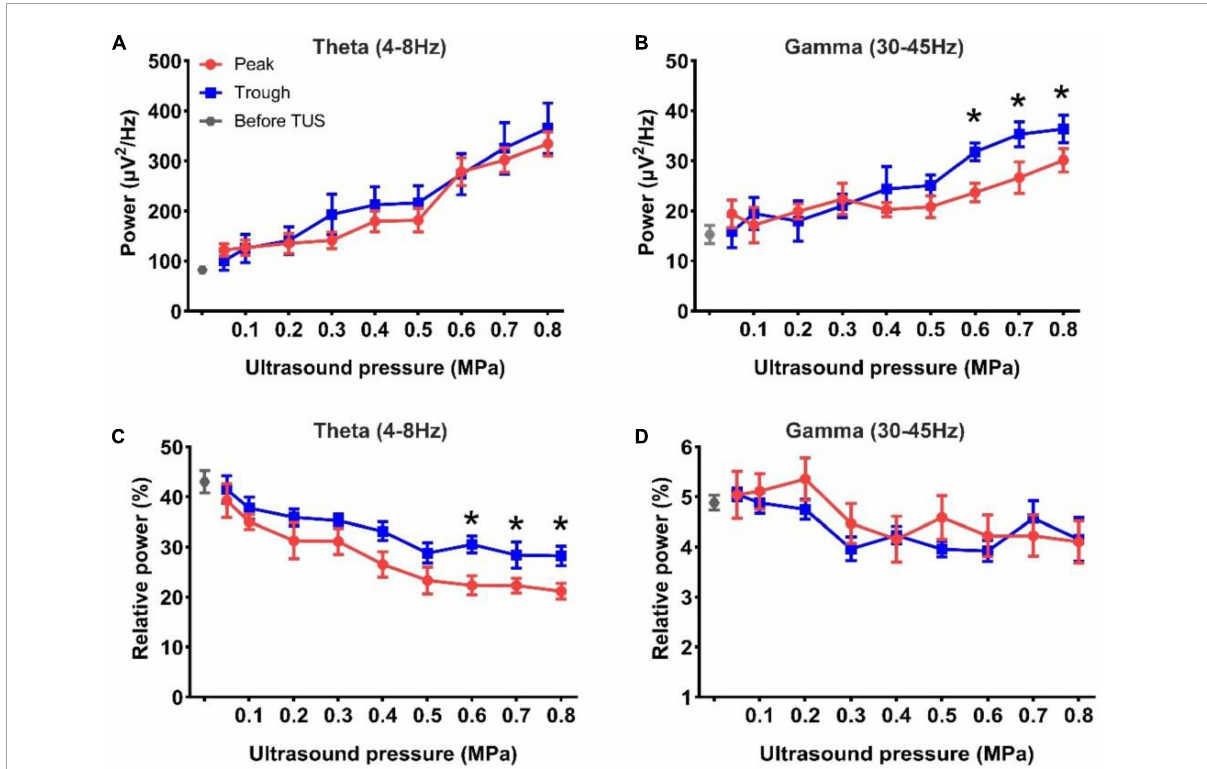
FIGURE3 (A,B) The absolute power of the theta and gamma rhythms before and after TUS under peak and trough stimulations with different ultrasound pressures, (A) theta rhythm, (B) gamma rhythm. (C,D) The relative power of the theta and gamma rhythms before and after TUS under peak and trough stimulations with different ultrasound pressures, (C) theta rhythm, (D) gamma rhythm. (mean ± SEM, n = 8 for peak stimulation, n = 8 for trough stimulation, * p < 0.05; Kruskal–Wallis test).